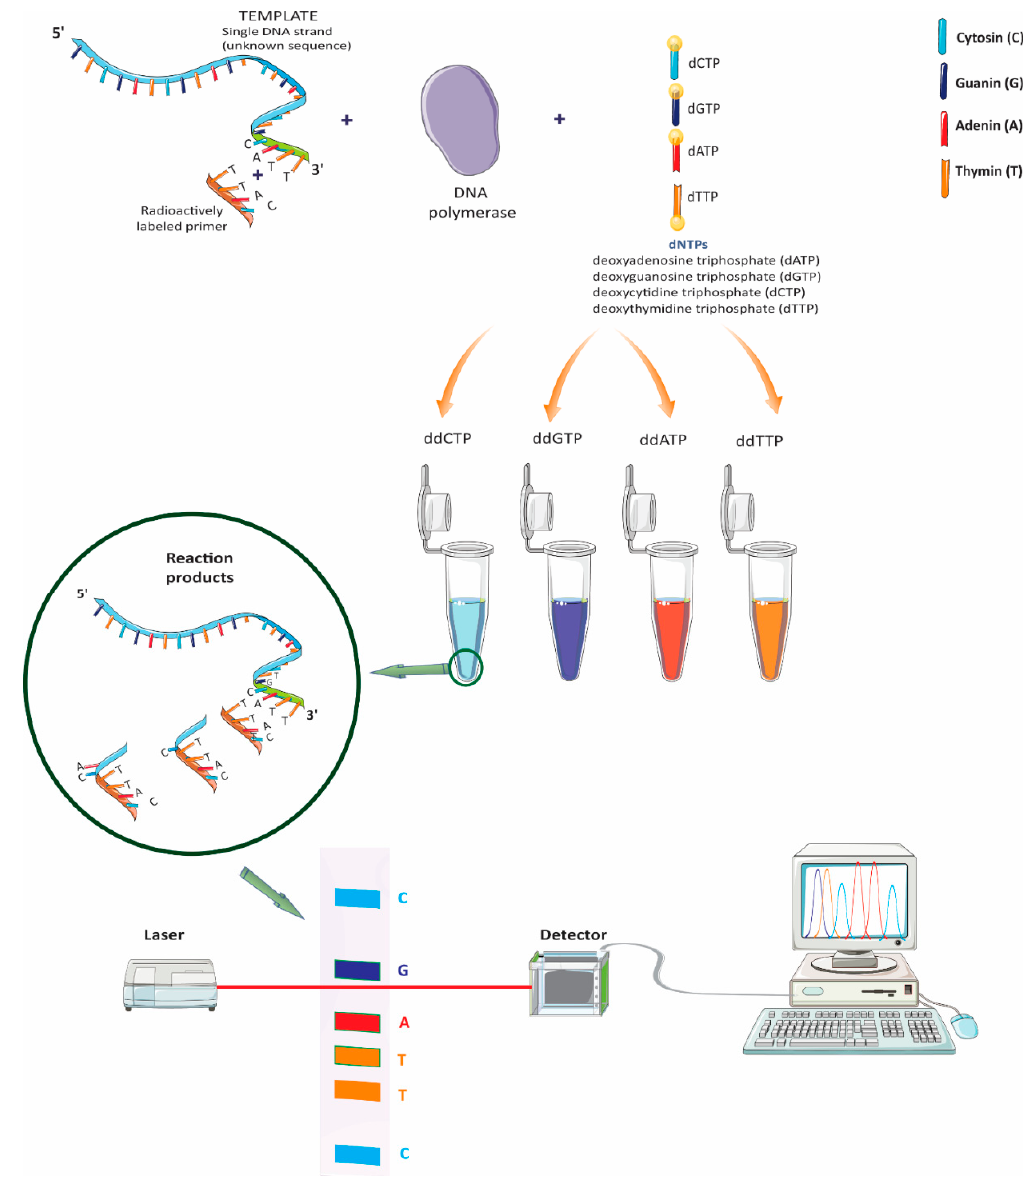
Figure 1. Sanger sequencing [11].